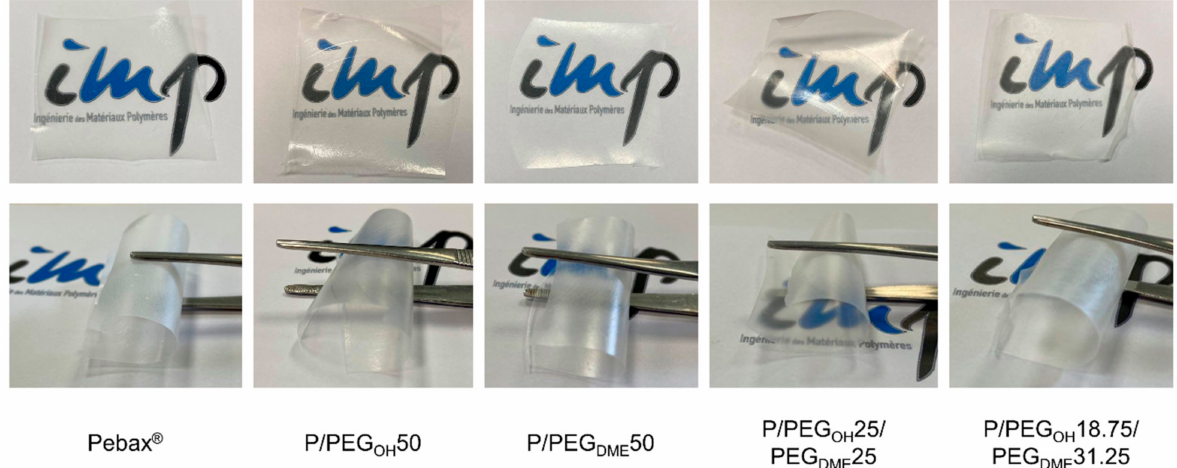
Figure 1. Visual observation of pristine Pebax ® and blended Pebax ® /PEG films with an additive content of 50 wt.% showing their transparency and flexibility properties.